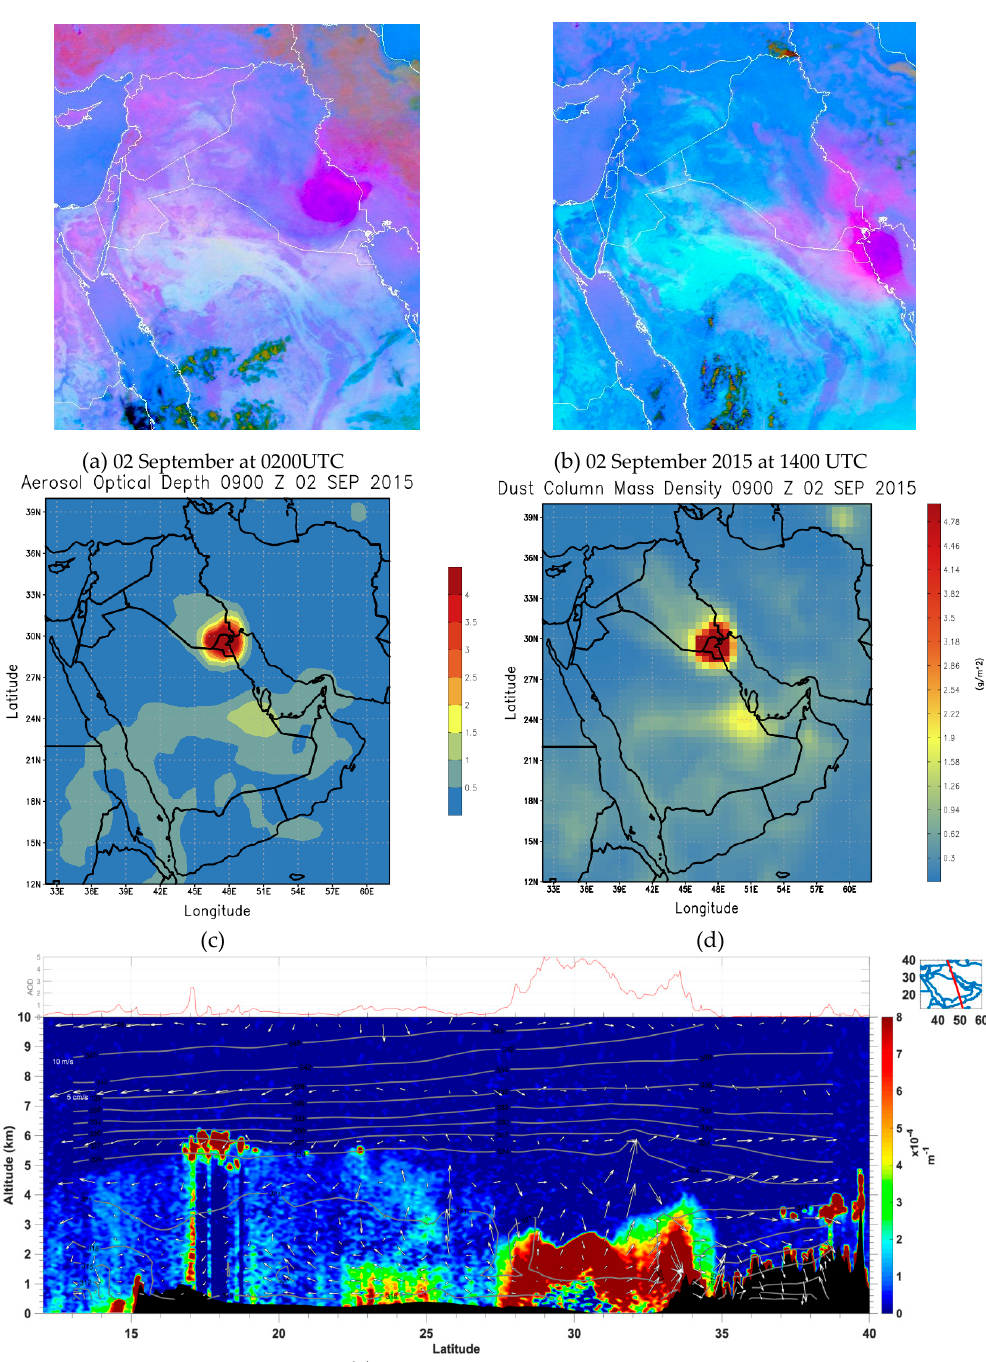
Figure 6. SEVIRI-derived false color images showing dust (pink/purple), clouds (brown/red) and differences in surface emissivity retrieved in absence of dust or clouds (light blue/blue) on 02 September at 0200UTC ( a ) and 02 September 2015 at 1400 UTC ( b ). ( c ) Aerosol optical depth and ( d ) dust column mass density derived from MERRA2 re-analyses on 02 September at 0900UTC. ( e ) CALIPSO observations on 2 September 2015 at 0700UTC of particle extinction coefficient at 532 nm on which are superimposed the wind direction and vertical velocities in vectors and the isentropes derived from ECMWF ERA5 re-analyses along CALIPSO track. The upper panel shows the AODs derived from CALIPSO at 532 nm along its path on 2 September 2015. The panel in the upper-right corner shows in red the path of CALIPSO over the study area on 2 September